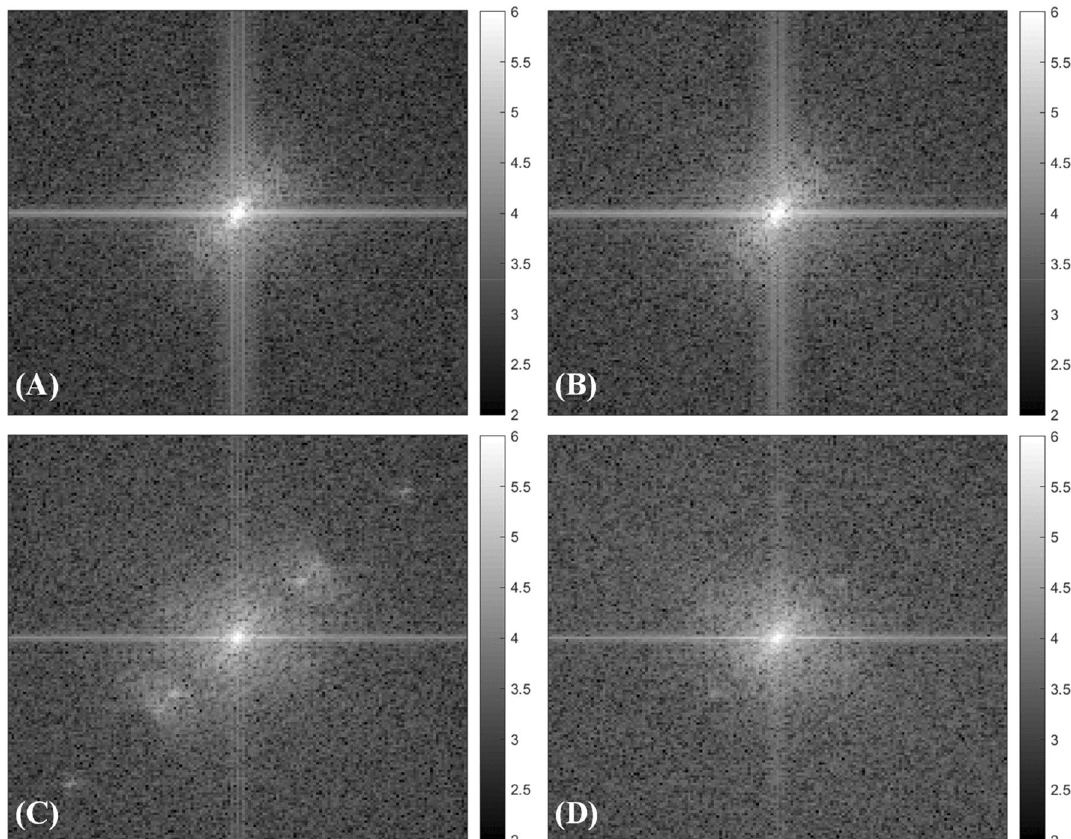
Figure 5. Power spectra of: ( A ) original TFMPEM image with uniform illumination, and reconstructed images obtained using: ( B ) HiLo, ( C ) Hilbert transform, and ( D ) Hilbert–Huang